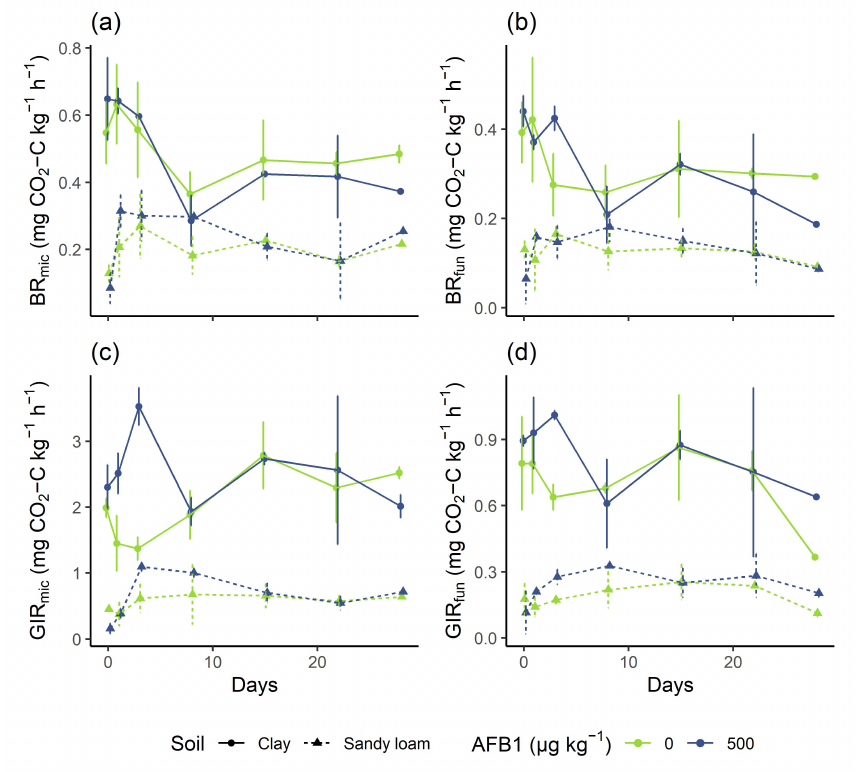
Figure 3. Microbial and fungal activity responses to AFB1 exposure as a function of the incubation time. Curve plots showing mean values for microbial basal respiration BR mic ( a ), microbial glucose- induced respiration GIR mic ( c ), fungal basal respiration BR fun ( b ), and fungal glucose-induced respiration GIR fun ( d ). The error bars represent the standard